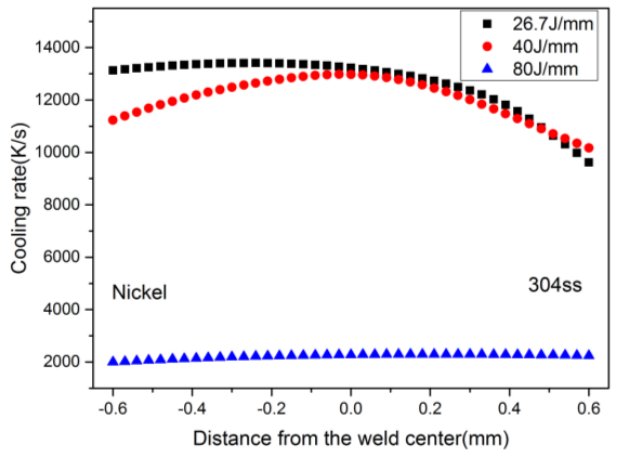
Figure 11. Spatial distribution of the cooling rate (GR) under different heat input.